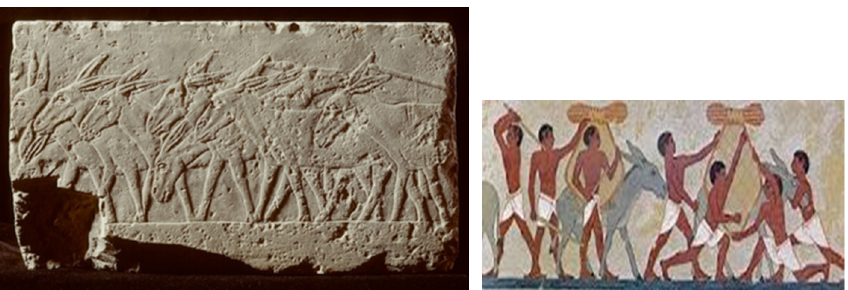
Figure 1. A bas ‐ relief and a panting from ancient Egypt showing the use of donkeys for daily works.